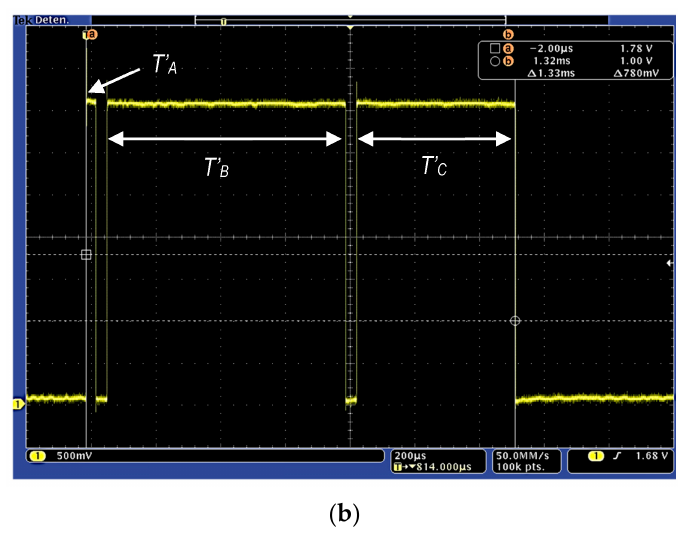
Figure 14. Computing time measurement for three different input values using ( a ) C library-based tanh(x) operation and ( b ) polynomial approach; Times correspond, respectively, to calculate the operations for inputs that meet: abs( x ) ≥ 5.3 ( (cid:1846) (cid:1827) , (cid:1846) (cid:1827) ′ ); 5.3 > abs( x ) > 0.9 ( (cid:1846) (cid:1828) , (cid:1846) (cid:1828) ′ ); and abs(x) ≤ 0.9 ( (cid:1846) (cid:1829) , (cid:1846) (cid:1829) ′ ).